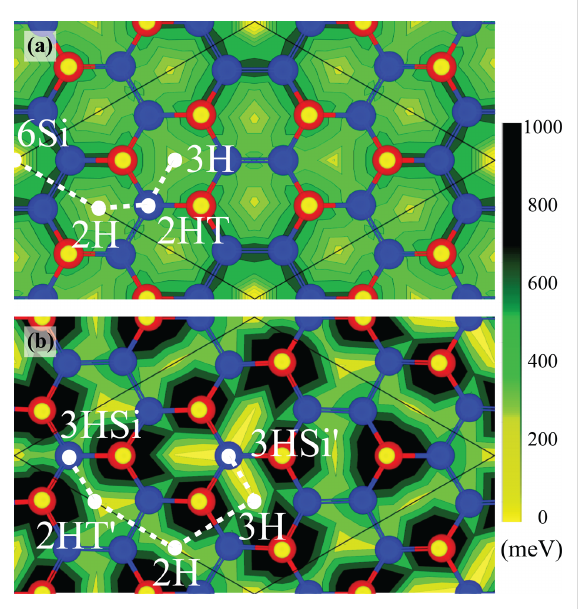
Figure 4: (Color online) Contour plots of the energy barriers (in meV) seen by Li atom adsorbed on (a) H- α -Si and (b) H- β -Si. Possible diffu- sion paths of Li on hydrogenated α and β silicene surfaces are illus- trated by white dashed